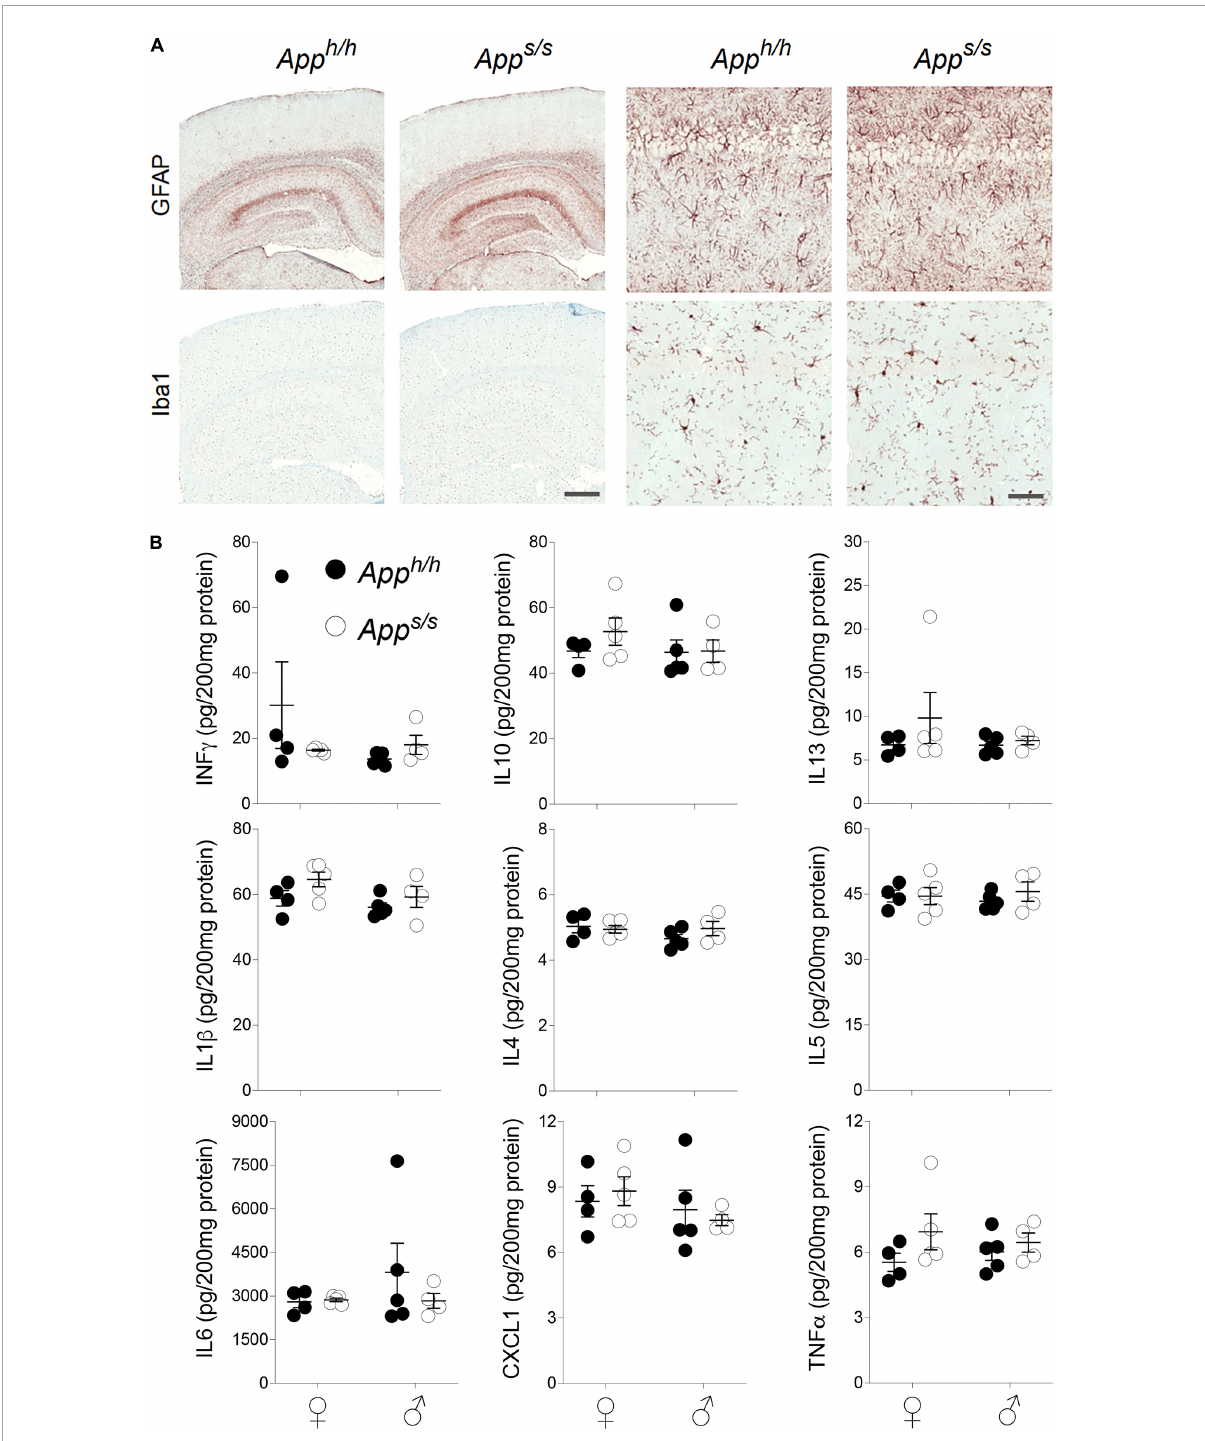
FIGURE7 Neuroinflammation analysis in App h / h and App s / s rats. (A) Histopathological analysis, using the astrocytes (GFAP) and microglia (Iba1) markers, of 14-month-old App h / h and App s / s rats ( App h / h , 5 male and 4 female rats, and App s / s , 5 male and 5 female). The left panels show representative images of the anterior hippocampus and overlaying somatosensory cortex of App h / h and App s / s rat brains. The scale bar is equivalent to 500 microns. The right panels show high-magnification picture of the hippocampal CA1 subregion for the staining depicted in the left panels. The scale bar is equivalent to 50 microns. (B) Levels of IFN- δ , IL-1 β , IL-4, IL-5, IL-6, CXCL1, IL-10, IL-13, and TNF- α in the CNS of 14 months old App h / h and App s / s rats ( App h / h , 5 male and 4 female rats, and App s / s , 4 male and 5 female) were measured by ELISA. Data are represented